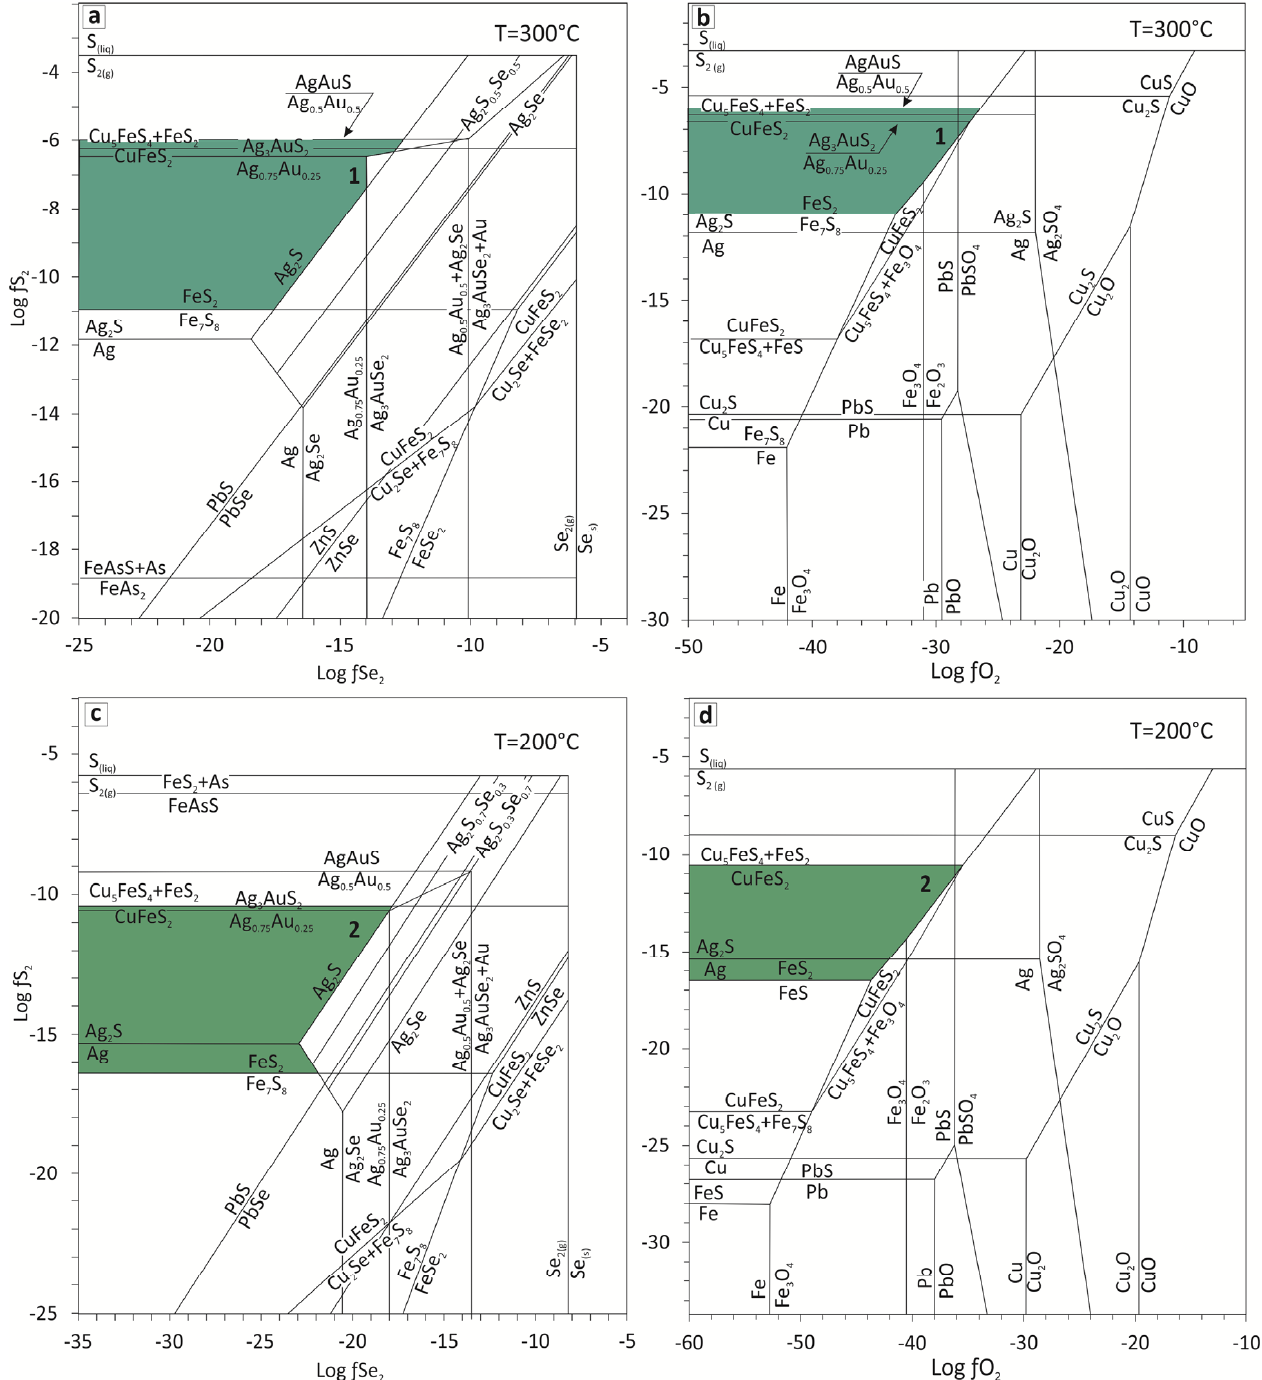
Figure 8. LogƒS 2 —logƒSe 2 and logƒS 2 —logƒ О 2 diagrams at 300°C ( а , b) and 200°C (c, d) and stability fields 326 LogƒS 2 —logƒSe 2 and logƒS 2 —logƒ О 2 diagrams at 300 ◦ C ( a , b ) and 200 ◦ C ( c , d ) and stabil- of the Corrida mineral associations: field 1 – pyrite + arsenopyrite + native gold + acanthite-1; field 2 – 327 ity fields of the Corrida mineral associations: field 1—pyrite + arsenopyrite + native gold + acanthite-1; field 2—pyrite + chalcopyrite + acanthite-2 + native pyrite + chalcopyrite + acanthite-2 + native silver. 328